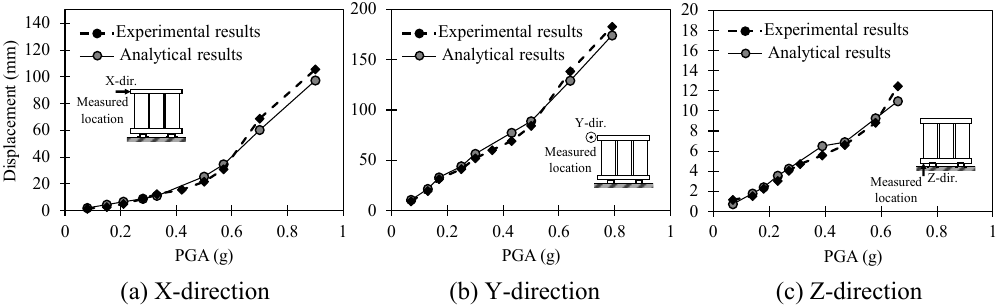
Figure 10. Comparison of maximum displacement of the mold transformer between analytical and experimental results.